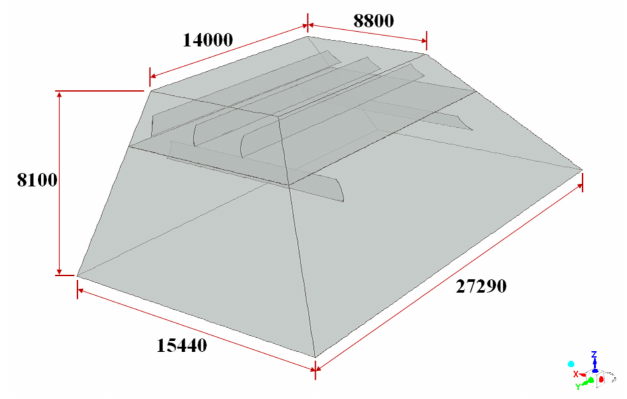
Figure 5. The baffles installation in the expansion duct for the optimal design (unit: mm).